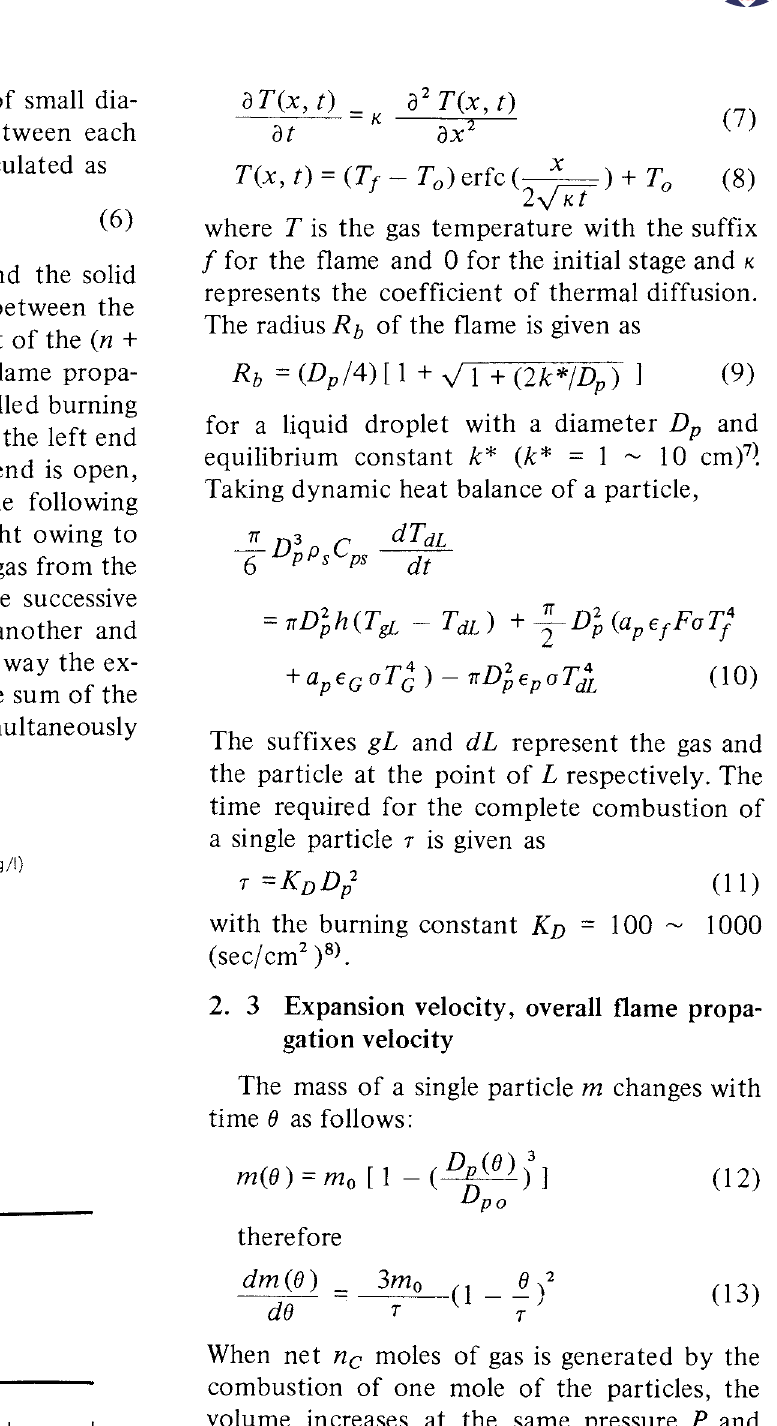
Fig. 5 Flame propagation time from n-th particle to (n + 1 )th